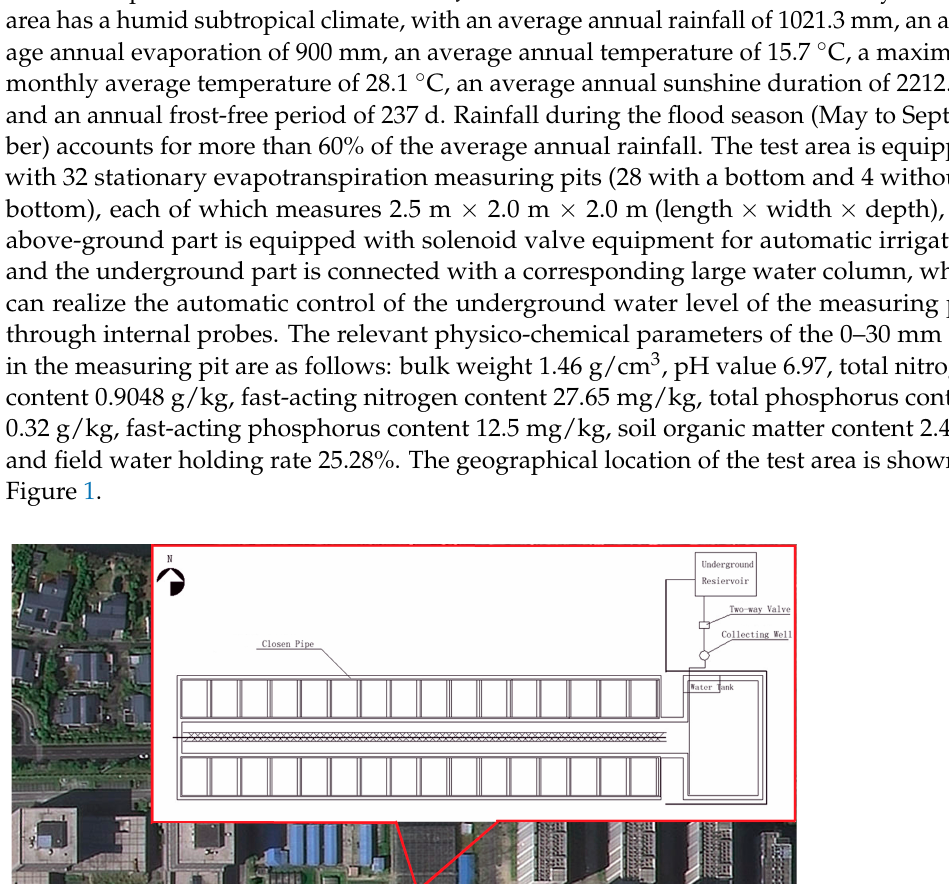
Figure 1. Water 2023 , 15 , x FOR PEER REVIEW